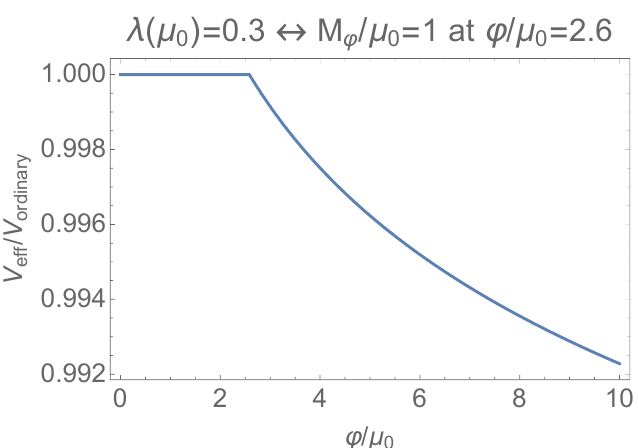
Figure 3 . The ratio of V ( ’ ) =V ( ’ ) is plotted as a function of ’=(cid:22) 0 in the case of (cid:20) = ordinary